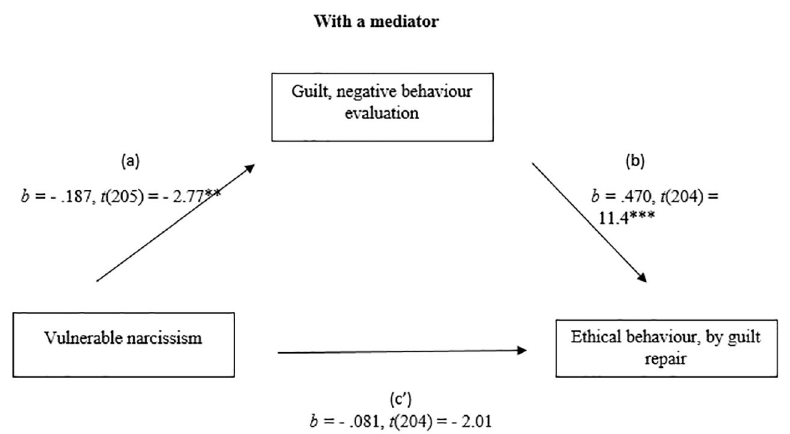
Figure 4. Mediation Analysis: With a mediator. * p < .05. ** p < .01. *** p <